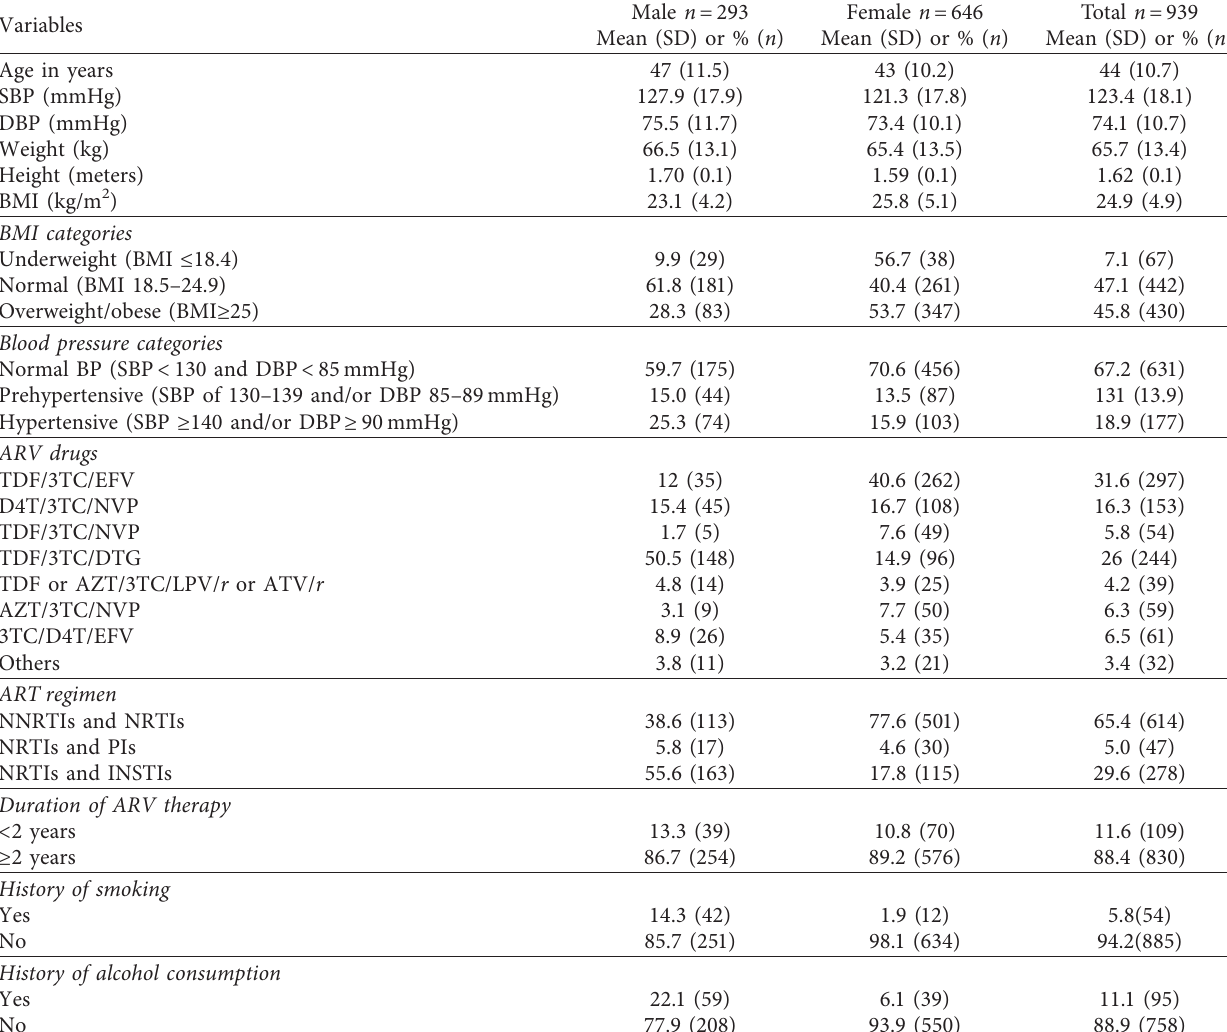
Table 1: Sociodemographic and clinical characteristics of the study